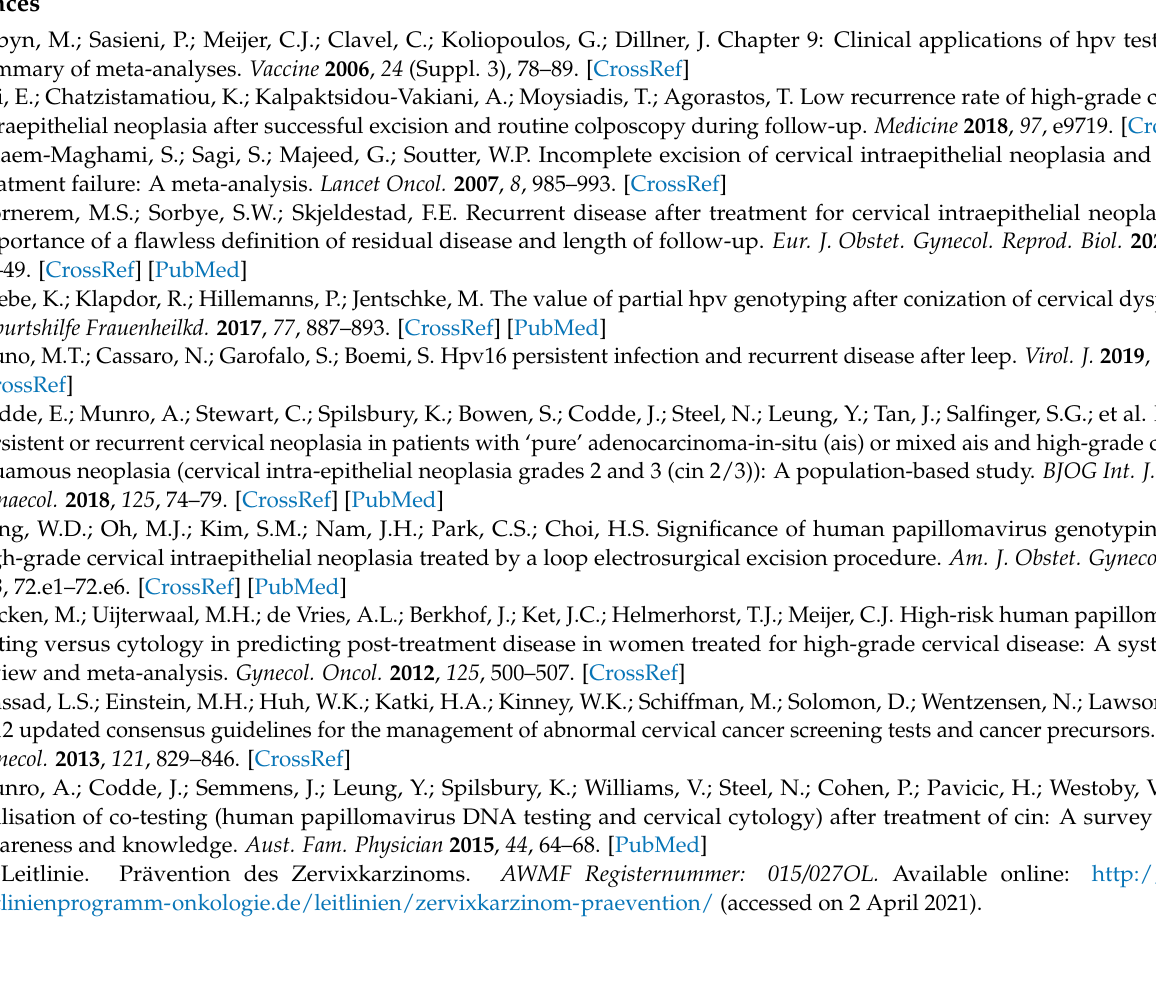
1 None of the tests revealed indeterminate results, the missing category shows the number of missing